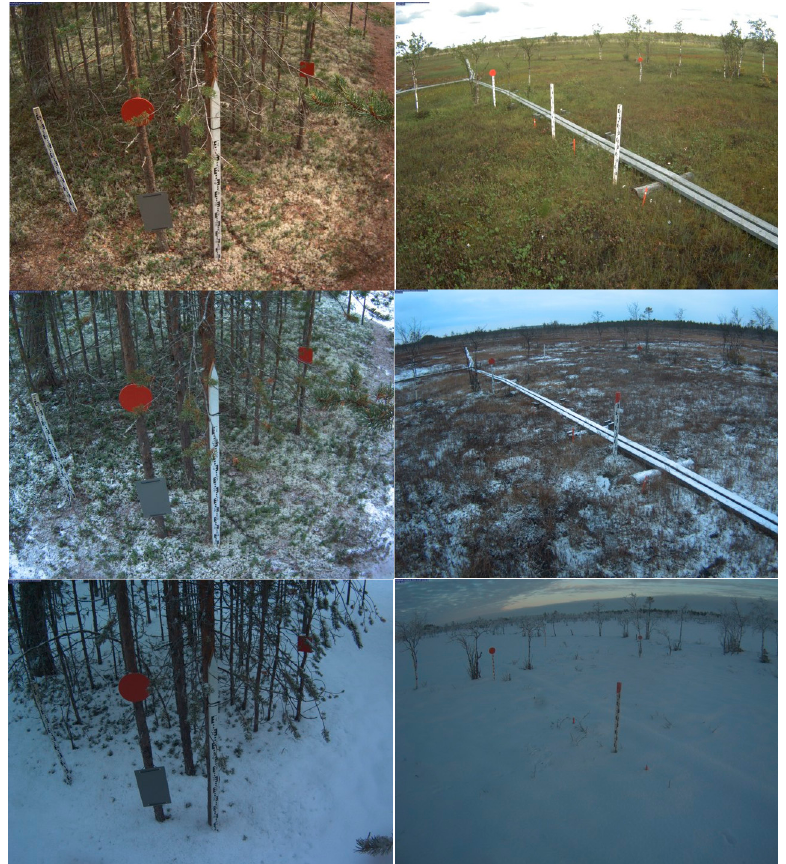
Figure 2. Example images in both summer and winter conditions from ground ( left panels ) and wetland cameras ( right panels ) of Sodankylä on 18 June 2016, 12:01 ( top ), 3 November 2016, 09:31 ( center ) and 25 November 2016, 11:01 ( bottom